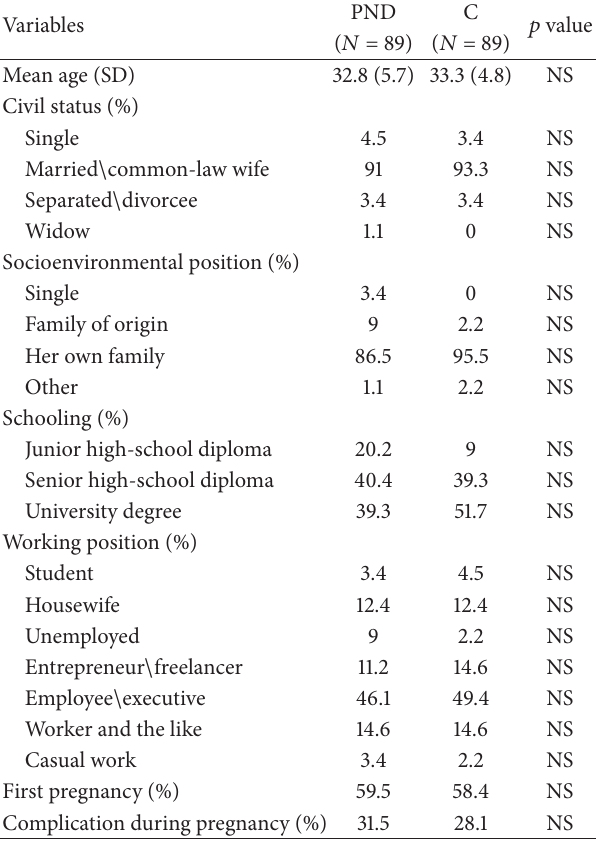
Table 1: Descriptive analysis of both groups: sociodemographics variables related to pregnancy ( 𝑡 -test).